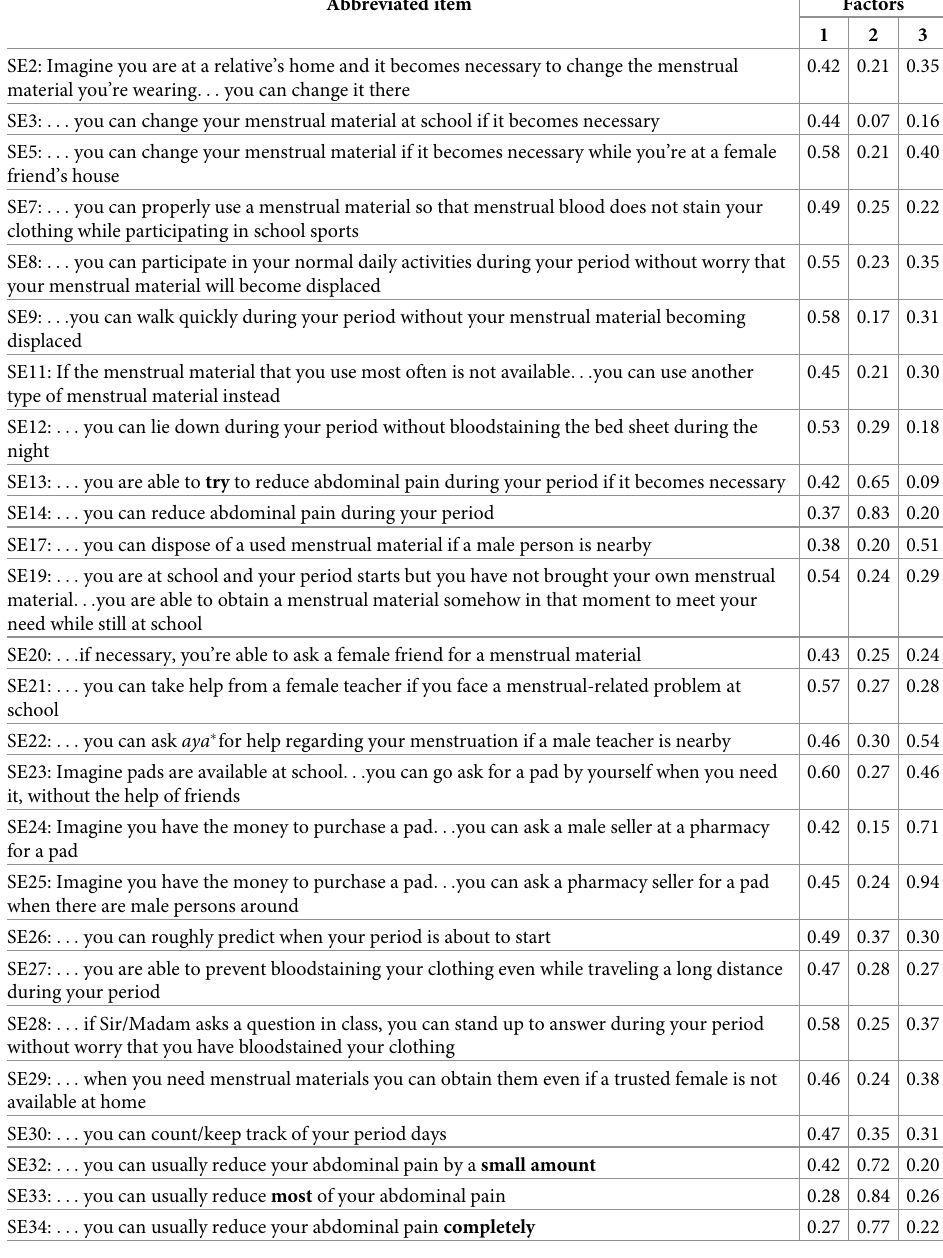
Table 3. (Structure matrix) correlations between Self-Efficacy in Addressing Menstrual Needs items and the obli- min oblique normalized rotated common factors (n = 381). Abbreviated item Factors 1 2